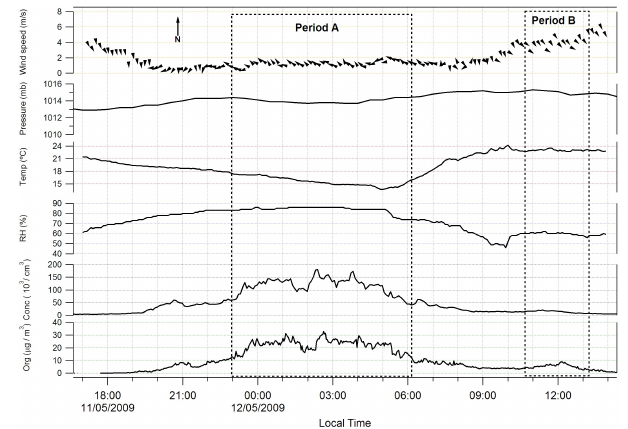
Fig. 1. The time series of the mass concentration of organics (µgm − 3 ) and the particle number concentration (cm − 3 ) , are pre- sented at two marked areas representing the burning event (Period A), and the following day at noon (Period B). The correspond- ing meteorological conditions (i.e. Temp (C ◦ ) , barometric pressure (mb), the wind speed (ms − 1 ) and wind direction) are presented as well. The average error of the organic mass is 0.025µmm − 3 for part A and 0.019µmm − 3 for part B.